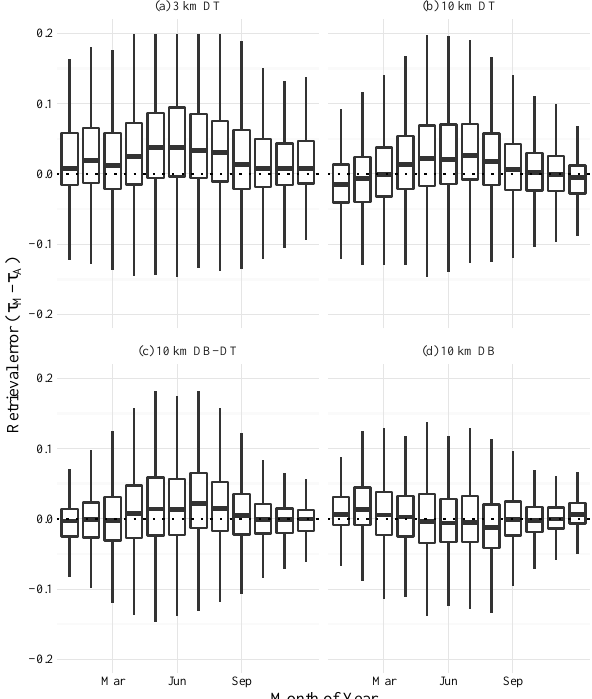
Figure 4. Boxplot showing the distribution of retrieval errors in MODIS AOD relative to AERONET, for each month of the year, for 3 km DT ( a ); 10 km DT ( b ); 10 km DB-DT ( c ); and 10 km DB ( d ). For each box, the midline represents the median, upper, and lower hinges represent the 25th and 75th percentiles, whiskers extend out to 5th and 95th